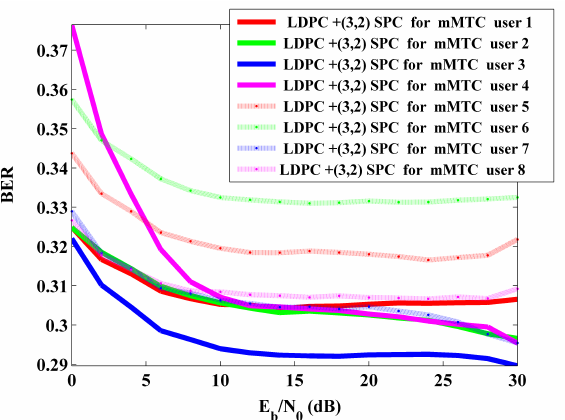
Figure 12. BER analysis of the proposed system adopting LDPC and (3,2) SPC concatenated channel- coding technique.